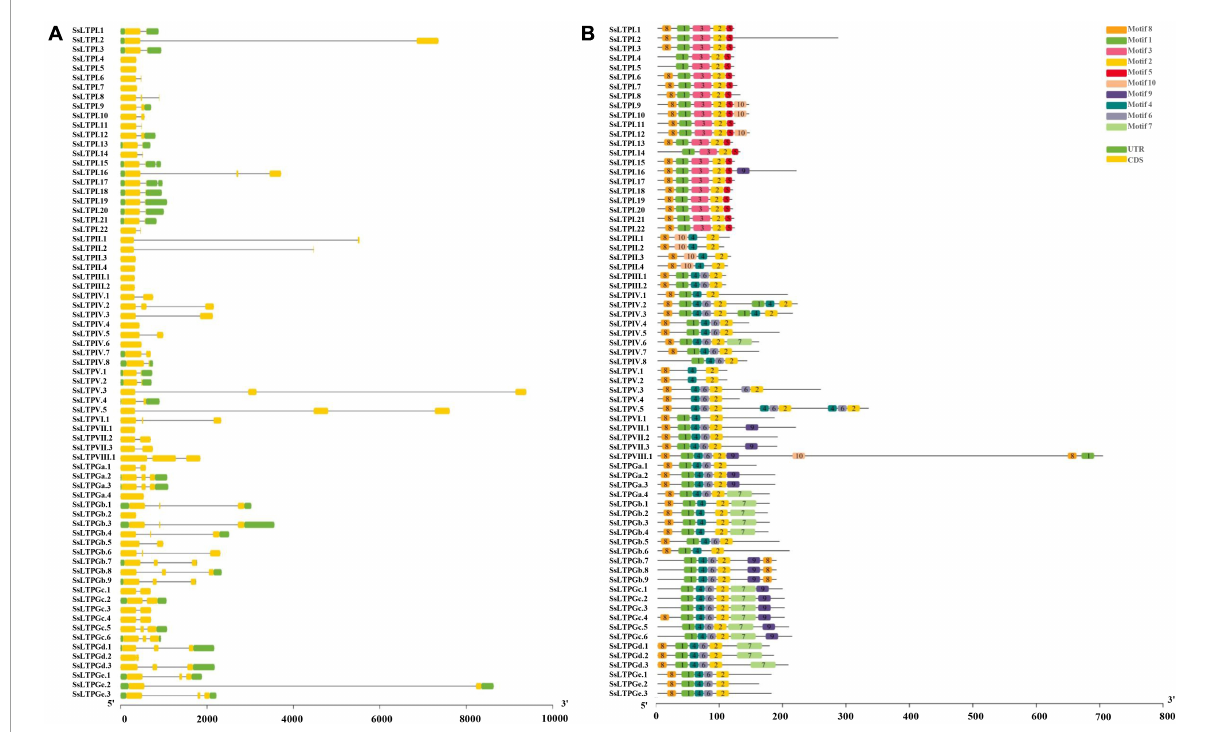
FIGURE3 Gene structure (A) and conserved motifs (B) among 71 SsnsLTPs genes in S. spontaneum . (A) Exons and untranslated regions are indicated by yellow and green boxes, respectively, and thin gray lines represent introns. The scale bar at the bottom represents the number of nucleotides. (B) Conserved motifs (1–10) identified using the MEME online database are represented by different color boxes. The scale bar at the bottom represents the number of base pairs (bp).